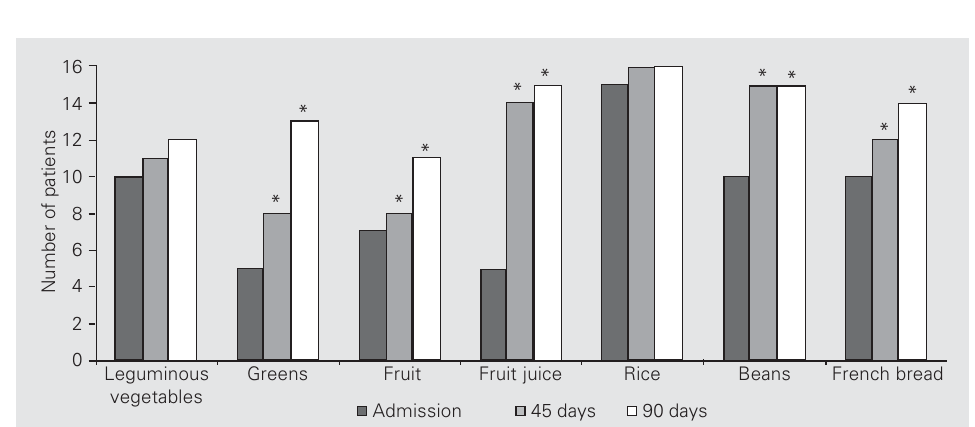
Figure 2. Food frequency of